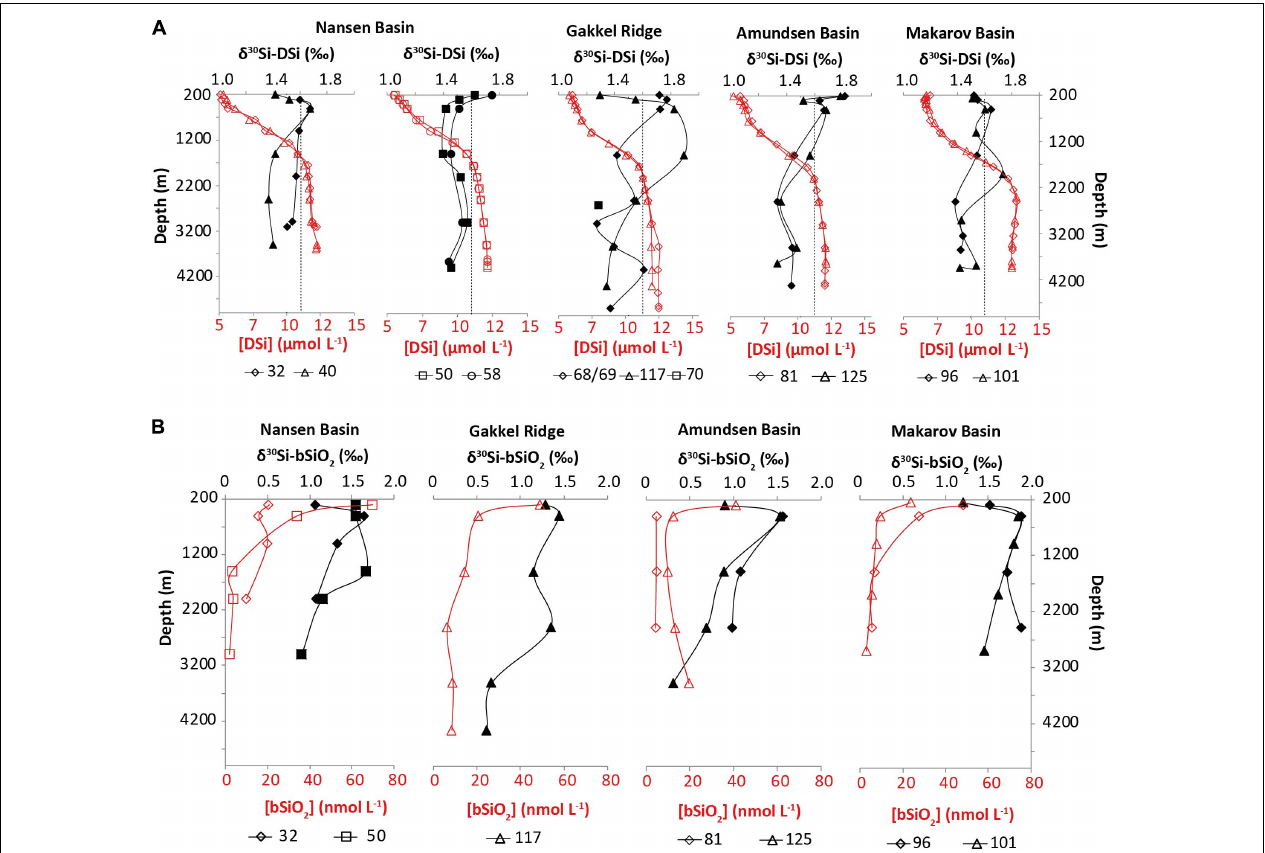
FIGURE 4 | (A) Water column profiles of δ 30 Si-DSi (black filled symbols) and [DSi] (red open symbols) for all stations separated by basin Nansen (32, 40, 50, and 58), Amundsen (81 and 125), and Makarov Basins (96 and 101) plus the stations above the Gakkel Ridge (69 and 117). The deep sample of station 70 is located at the depth of the hydrothermal plume. The dotted line represents the Atlantic Water endmember δ 30 Si-DSi of 1.6 δ 30 Si-bSiO 2 (black filled symbols) and [bSiO 2 ] (red open symbols) for all stations separated by basin Nansen (32 and 50), Amundsen (81 and 125), and Makarov Basins (96 and 101) plus the station above the Gakkel Ridge